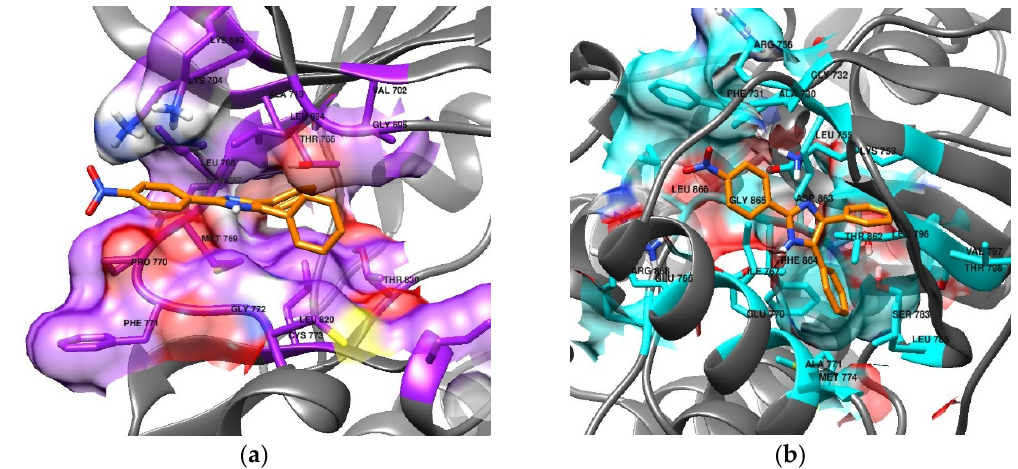
Figure 4. Compound 11 (orange) depicted with both of the analyzed receptors. Highlighted are the residues at distances < 5.0 Å from 11 , with some surfaces active to show the cavity in which the docking analysis put the best docked pose. ( a ) EGFR, with the near residues in purple. ( b ) HER2, with the near residues in cyan.